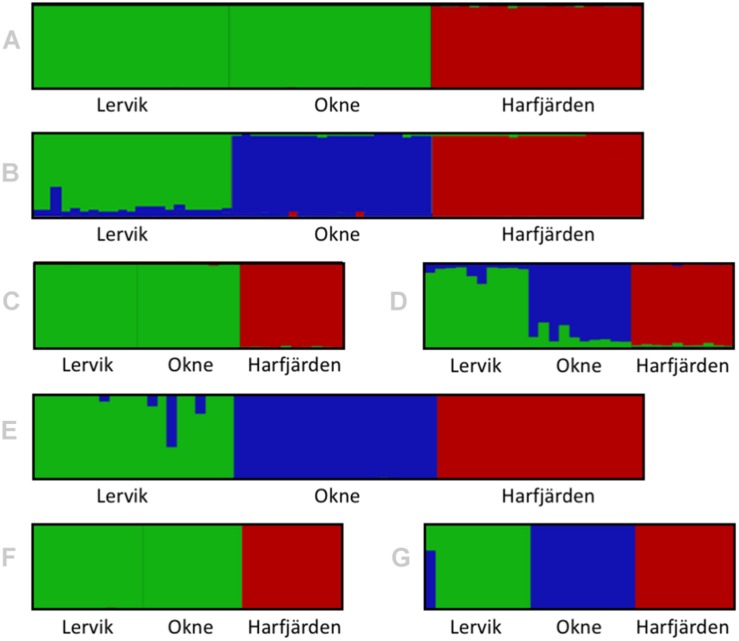
Structure/distruct-plots for the most likely number of genetic clusters (K) in the sampled individuals for full (N = 64) and subset (N = 30) datasets for both microsatellites analyzed with STRUCTURE (A–D), and RADseq SNPs analyzed with fastSTRUCTURE (E–G). Plots show the results for (A) full microsatellite dataset for K = 2, (B) full microsatellite dataset for K = 3, (C) subset microsatellite dataset for K = 2, (D) subset microsatellite dataset for K = 3, (E) full RADseq SNP dataset for K = 3, (F) subset RADseq SNP dataset for K = 2, and (G) subset RADseq SNP dataset for K = 3.